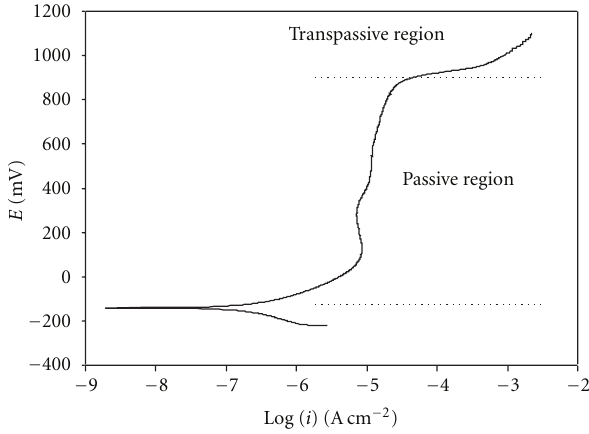
Figure 2: Potentiodynamic polarizationcurve for AISI 321 stainless steel in 0.5MH 2 SO 4